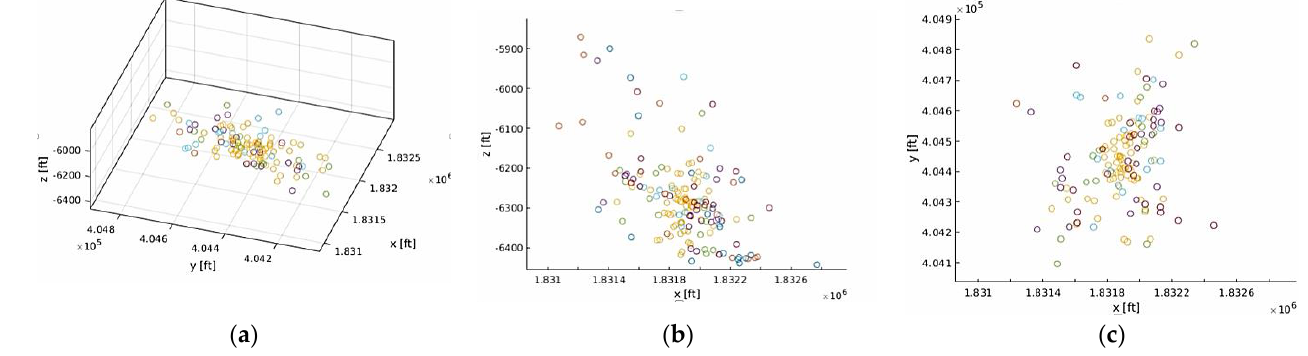
Figure 5. Example of MS event observed in MIP-3H stage 7. ( a – c ) 3D view and two vertical planes respectively. The microseismic events are color-coded for each step (a period with a unique fluid, pump, and proppant properties inside a specific stage, where each stage could be divided into